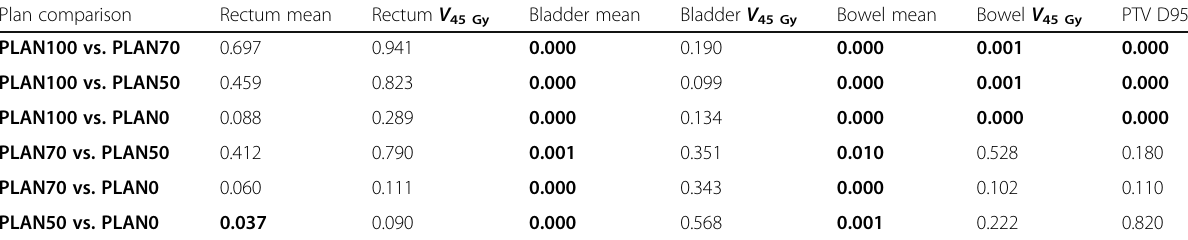
Table 3 p value of dosimetric variables on comparing different radiotherapy plans Plan